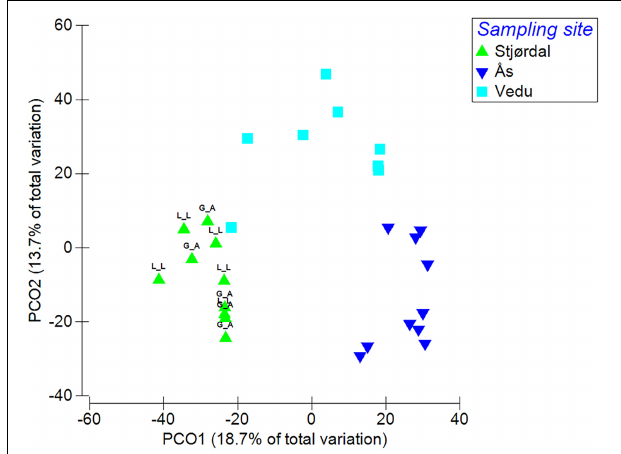
FIGURE 4 | Species composition differences between the three sites (L_L refers to subsamples taken from leaflet lesion area and G_A to subsamples from green leaflet area). Data were square root transformed and resemblance calculated by S17 Bray-Curtis similarity.